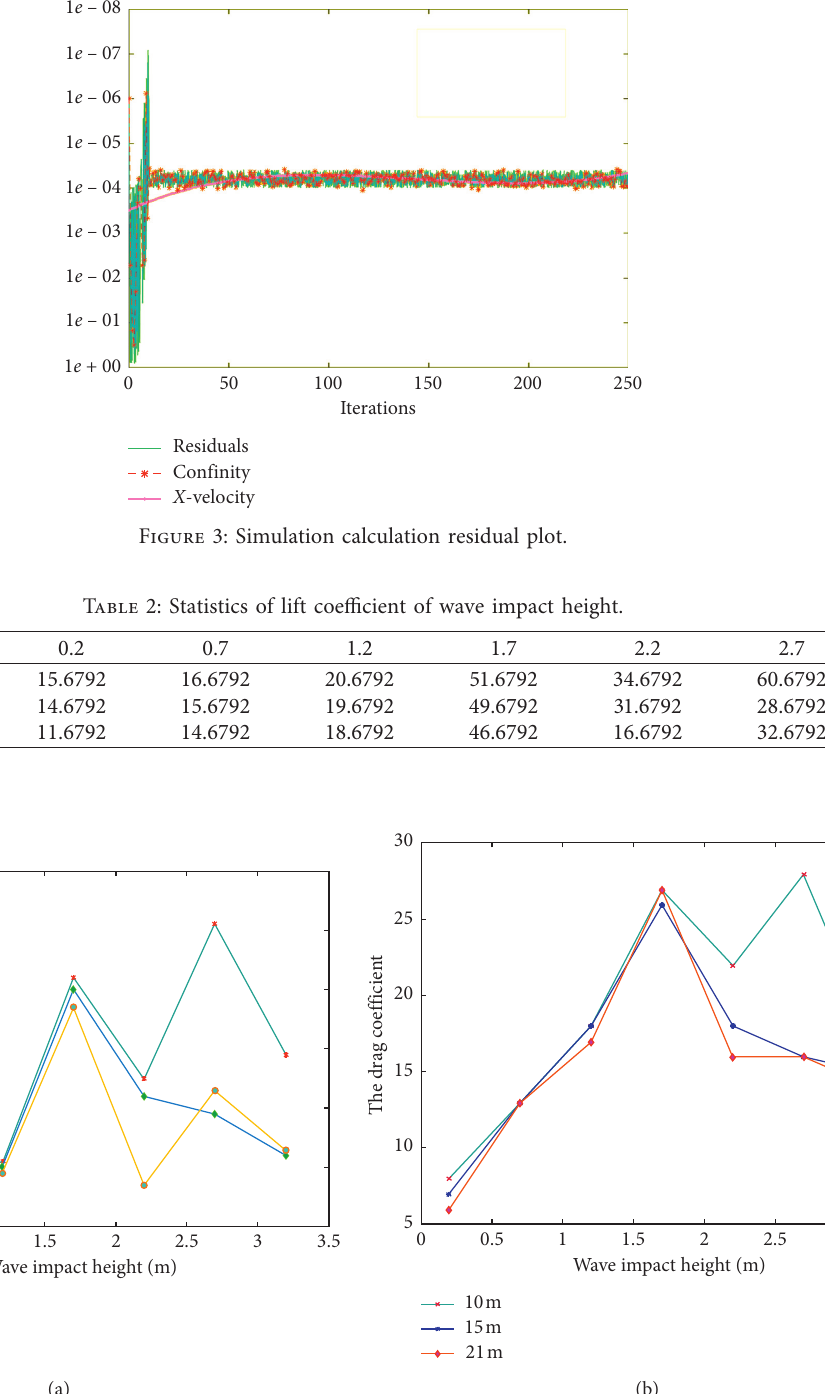
Figure 4: Analysis of the lift coefficient and drag coefficient in different water depths in case of working conditions. (a) Lift coefficient. (b) Resistance coefficient. Table 3: 20 analysis of lift coefficient and resistance coefficient of different water depths in case of working conditions. Wave impact height (m)